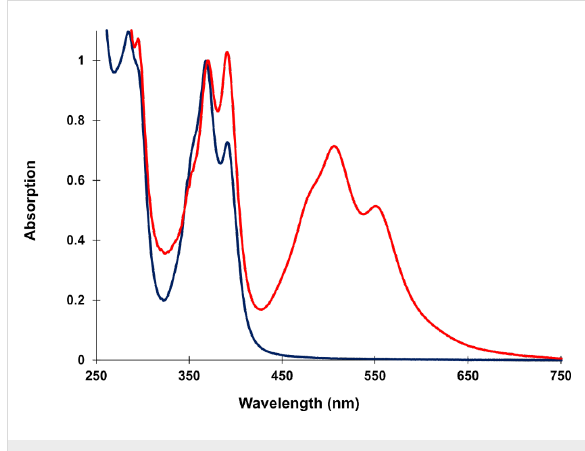
Figure 3: UV–vis absorption spectra (scaled) of duplexes 1*2 (blue) and 1*6 (red) at 20 °C. Conditions: see Table 1.